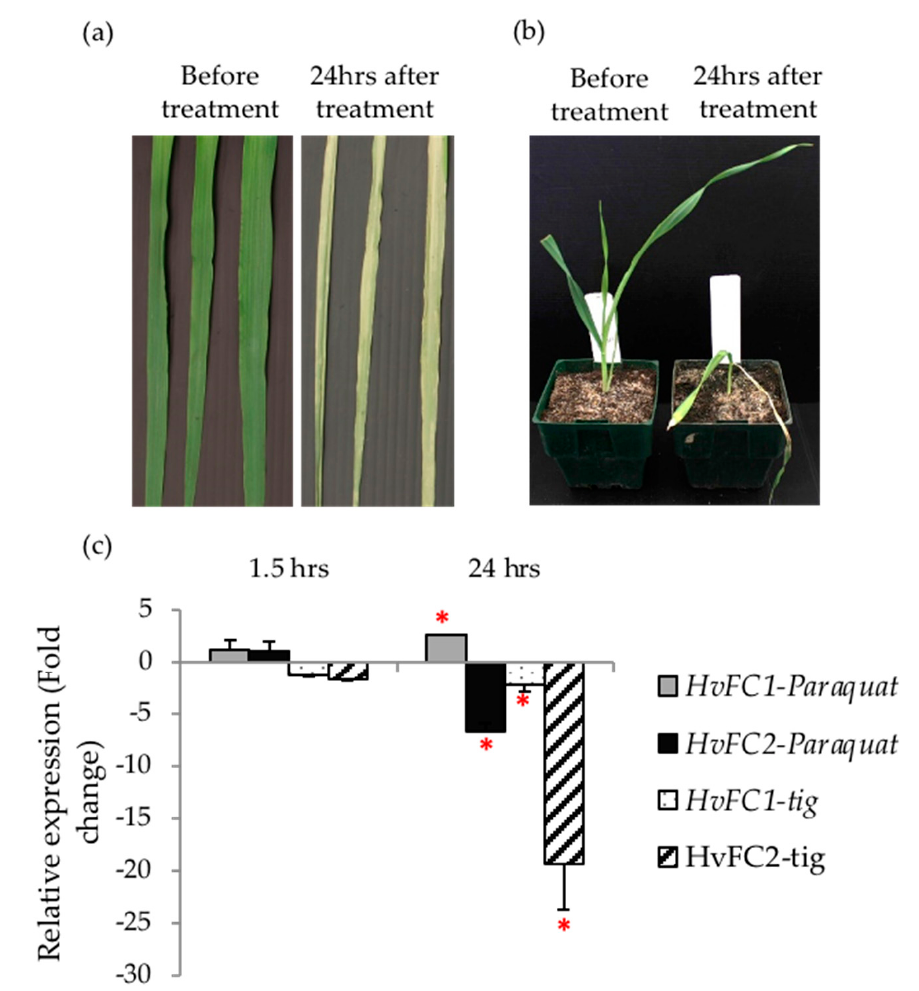
Figure 9. Phenotypes of control barley leaves and HvFC transcript abundance upon exposure to Paraquat-induced and tetrapyrrole-mediated oxidative stress. Leaves of control plants before and 24 h after exposure to ( a ) Paraquat-induced oxidative stress, and ( b ) tetrapyrrole-mediated oxidative stress in tigrina d12 mutants. ( c ) Relative expression of HvFC1 and HvFC2 , upon oxidative stress relative to before stress. The data are shown as mean ± standard error (SE) of 3 different plants. Asterisks indicate a statistically significant expression difference, relative to before treatment, at * p < 0.05 using one-way ANOVA.